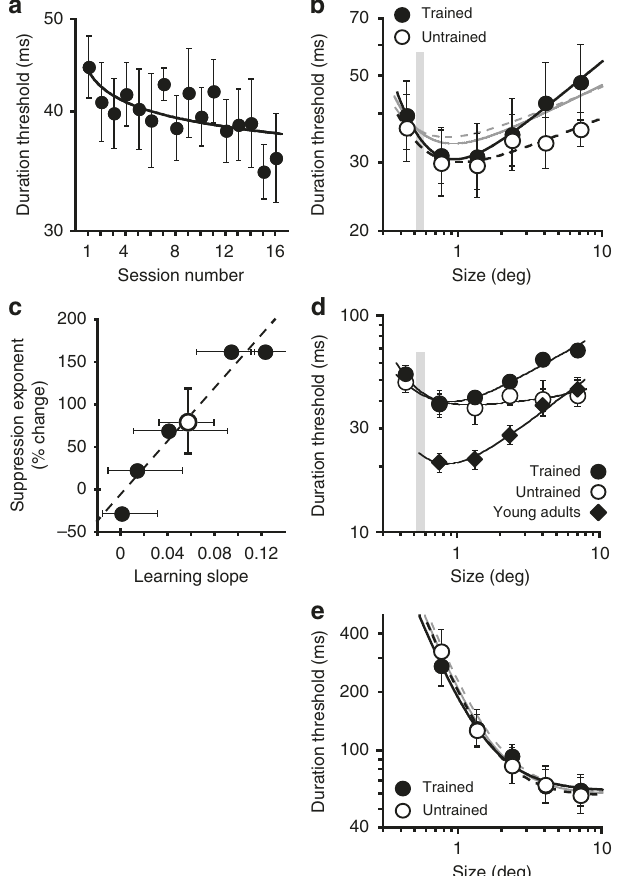
Fig. 6 Perceptual learning of motion segregation affects spatial suppression. a Motion segregation performance as a function of the training session. Data were fi t with an exponential function. Error bars are s.e.m. b Comparison of pre- and post-training motion direction discriminations at high contrast. Black lines are descriptive model fi ts to the post-training data (see “ Methods ” section), with the solid line indicating the trained motion direction. Gray lines are fi ts to the pre-training data. For clarity, pre-training thresholds are omitted and can be seen in Fig. 5a. Error bars are s.e.m. c The relationship between the amount of perceptual learning and the resultant change in spatial suppression strength for the trained motion direction. Error bars are 95% CI, revealing signi fi cant learning in 3 observers. The empty circle shows the average overall observers, with s.e. m as error bars. d Same as ( b ), except only showing data for observers who exhibited signi fi cant perceptual learning. For comparison, data for young adults is replotted from Fig. 5b (averaged over motion direction). Note that the y -axis is larger than in ( b ) to accommodate young adult data. e Same as ( b ), but for low contrast